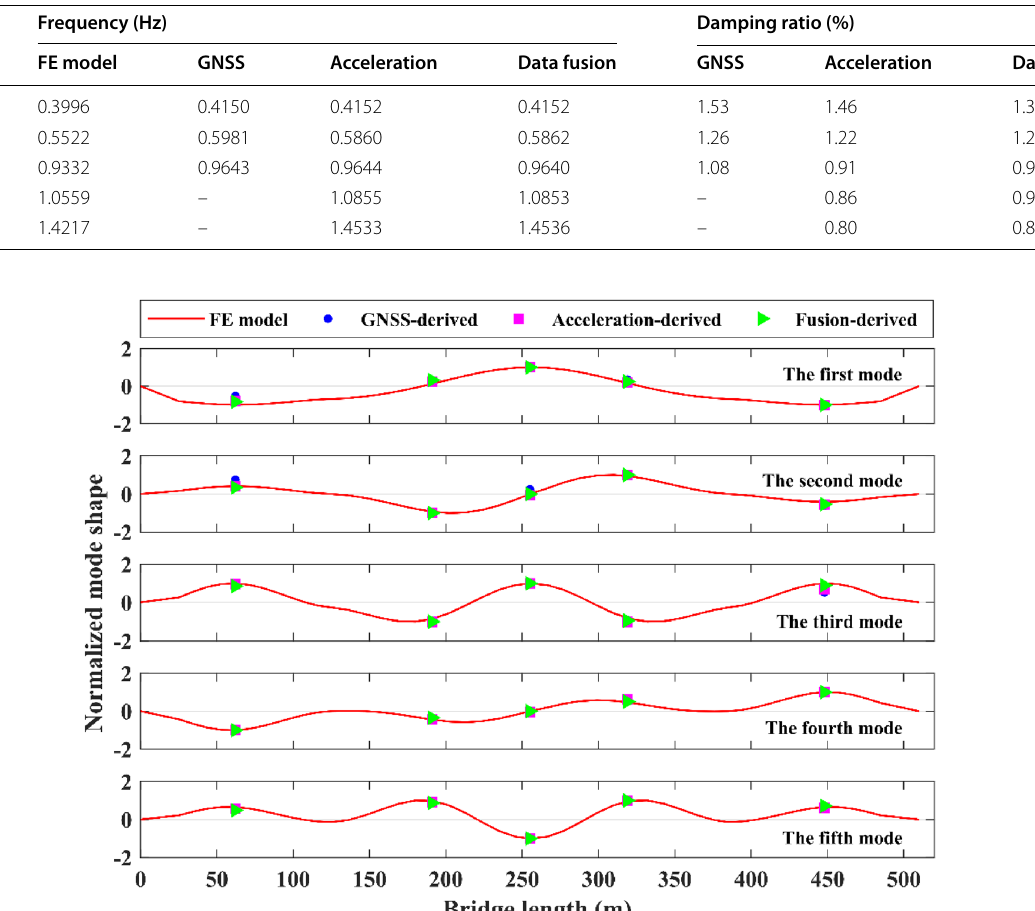
Table 3 Estimated modal parameters for Tianjin Yonghe Bridge based on field measurement